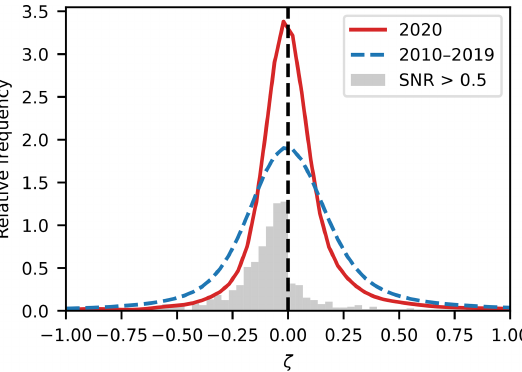
Figure 6. Median profiles of normalised temperature standard de- viations (ITCs) in unstable conditions (solid lines) for three wind sectors: (a) campus buildings, (b) main road, and (c) vegetation, with the p 25–75 interpercentile range shaded. The corresponding estimates from the EC system are marked with × symbols, and ref- erence similarity functions are drawn using dashed